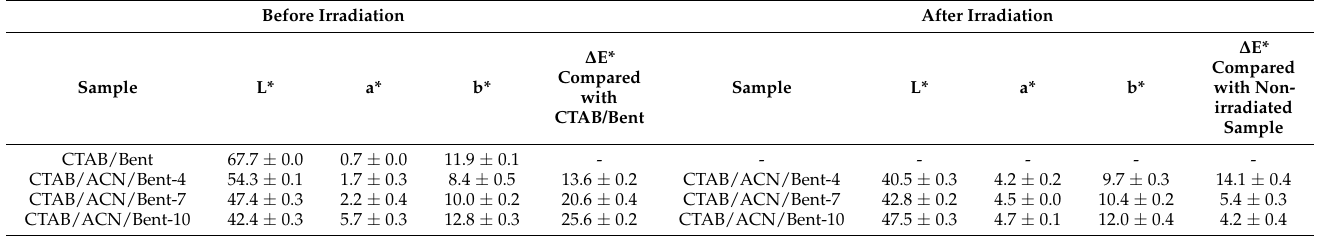
Table 2. Total color differences ( ∆ E*) for each pigment compared with CTAB/Bent precursor and after 200 h of